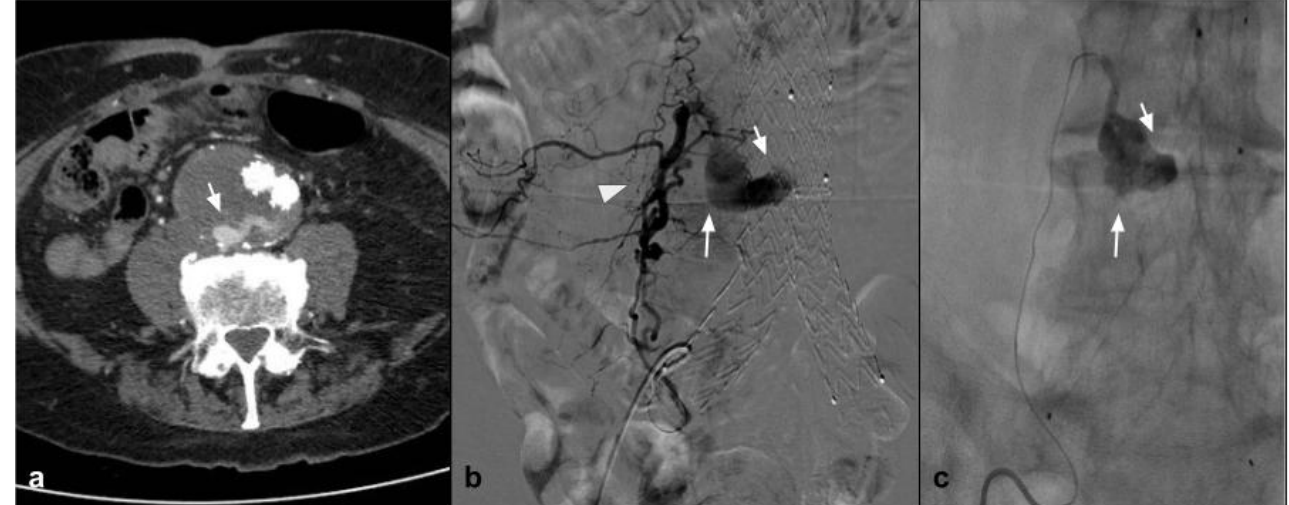
Figure 3. ( a ) Axial CTA shows, the presence of Type II endoleak after EVAR, supplied by lumbar arteries (white arrow). ( b ) DSA performed with microcatheter positioned in a lumbar branch through the ilio-lumbar artery highlights the presence of hypertrophic lumbar circles (white arrow head) with sac refuelling (white arrow). ( c ) Post-procedure DSA shows the cast of Squid 12, which completely occupies the space of the endoleak in the sac (white arrow).